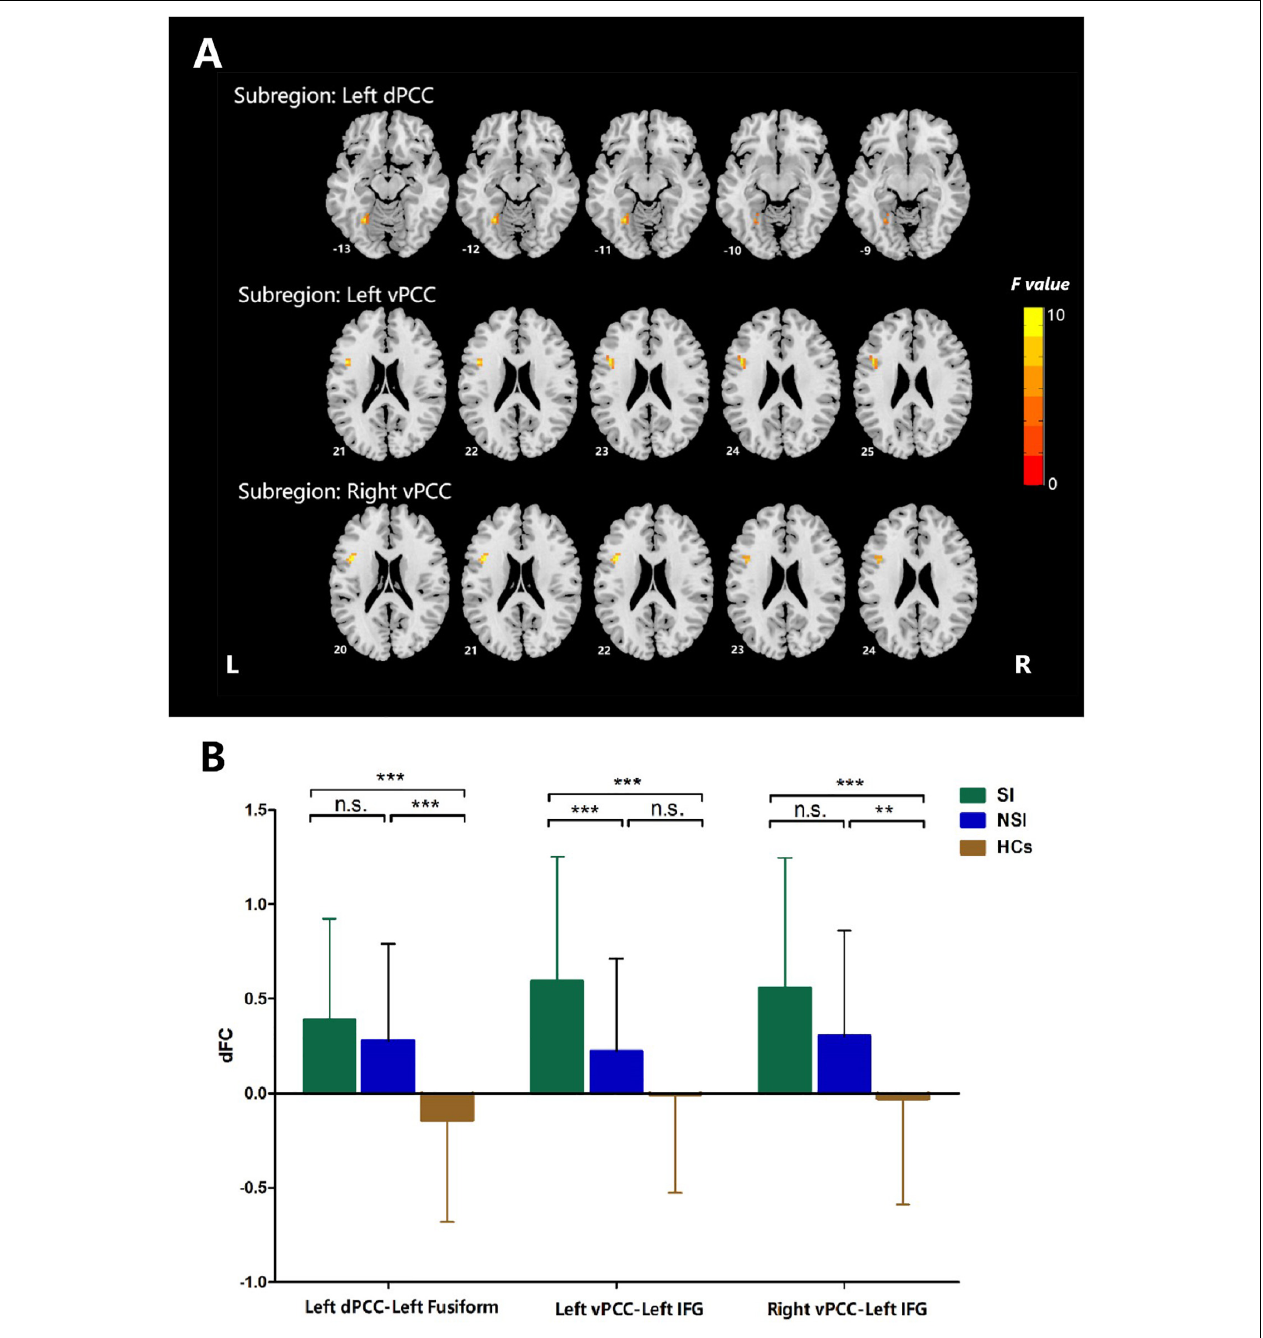
FIGURE 3 | ANCOVA analyses of dFC values among three groups when taking the subregion of posterior cingulate cortex as a seed. (A) Brain regions with significant differences among three groups, voxel p < 0.005, cluster p < 0.0125, GRF corrected. (B) Post hoc analyses of dFC values among three groups. Bonferroni corrected. dFC, dynamic functional connectivity; vPCC, ventral posterior cingulate cortex; dPCC, dorsal posterior cingulate cortex; IFG, inferior frontal gyrus; SI, major depressive patients with suicidal ideation; NSI, major depressive patients without suicidal ideation; HCs, heathy controls. n.s., not significant. ** p < 0.01, *** p <